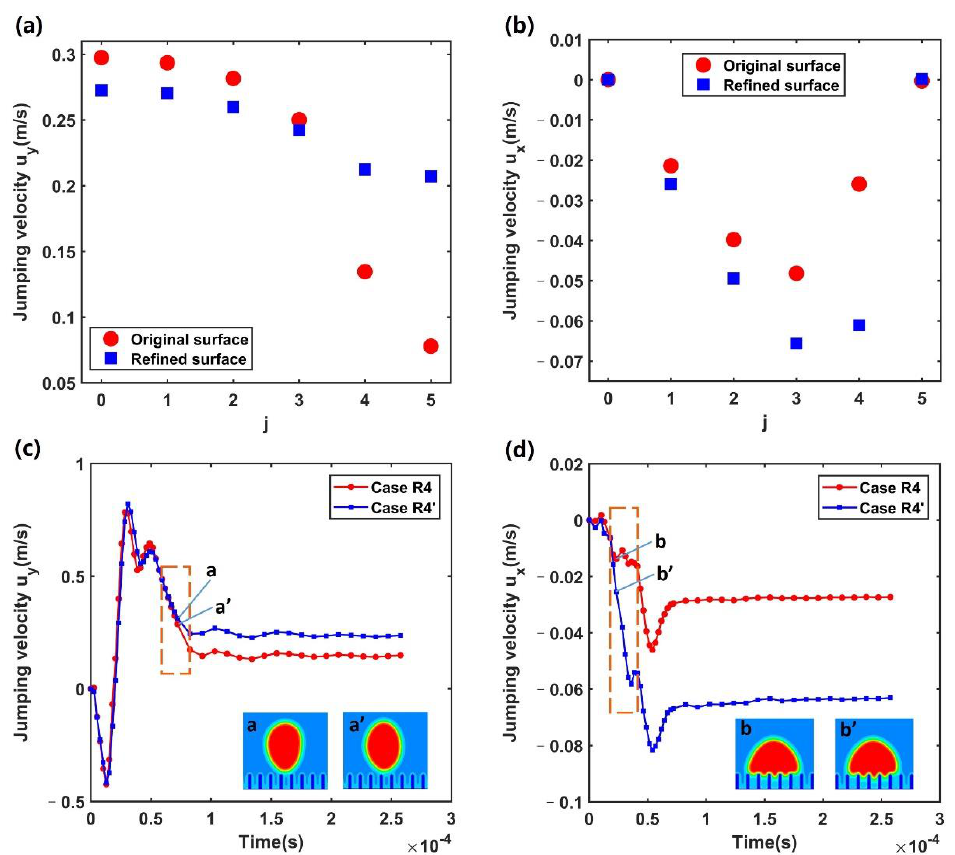
Figure 8. ( a , b ) Comparison of droplet jumping velocity at t = 0.515 ms. ( c , d ) Comparison of droplet velocity – time evolution in Case R 4 and Case R 4 ’ .